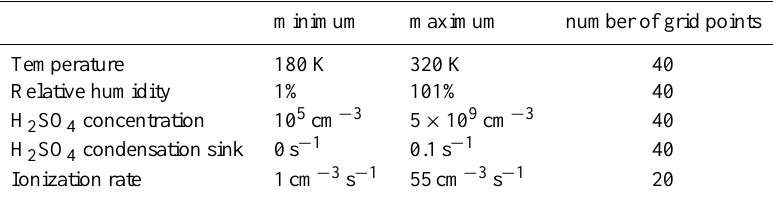
Table 1. Grid of parameters on which the particle formation rate from neutral and charged H 2 SO 4 /H 2 O nucleation is defined. Sulfuric acid concentrations up to 5 × 10 9 cm − 3 , although not common in the atmosphere, are covered in order to accommodate the model spin-up phase, when the H 2 SO 4 condensation sink is very small and H 2 SO 4 concentrations high. The relative humidity lower limit of 1% covers locations up to a pressure level of ∼ 30hPa, above which nucleation is negligible in background conditions. For stratospheric applications, e.g. simulations of large volcanic eruptions, a grid extending to relative humidities below 1% is